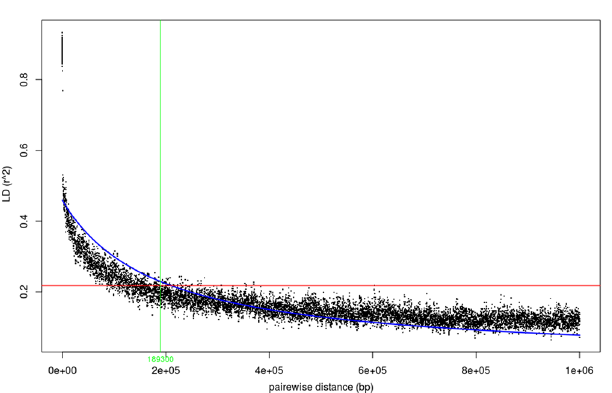
Figure 2. Linkage disequilibrium plotted over genetic distance , with r 2 dropping below 0.1 at inter-marker distance beyond 1